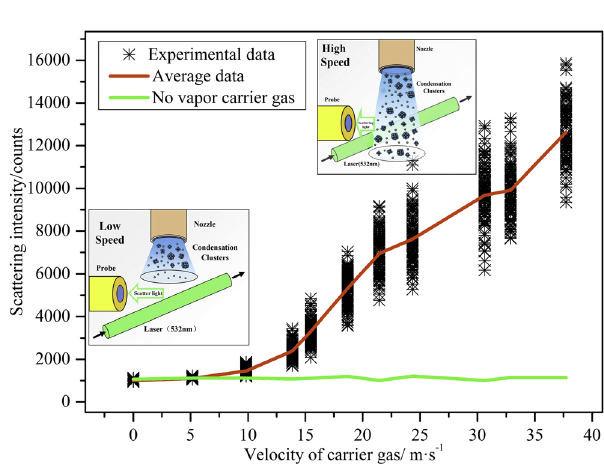
Figure 4. Clusters jet scattering intensity affected by carrier gas flux ( Δ T = 15